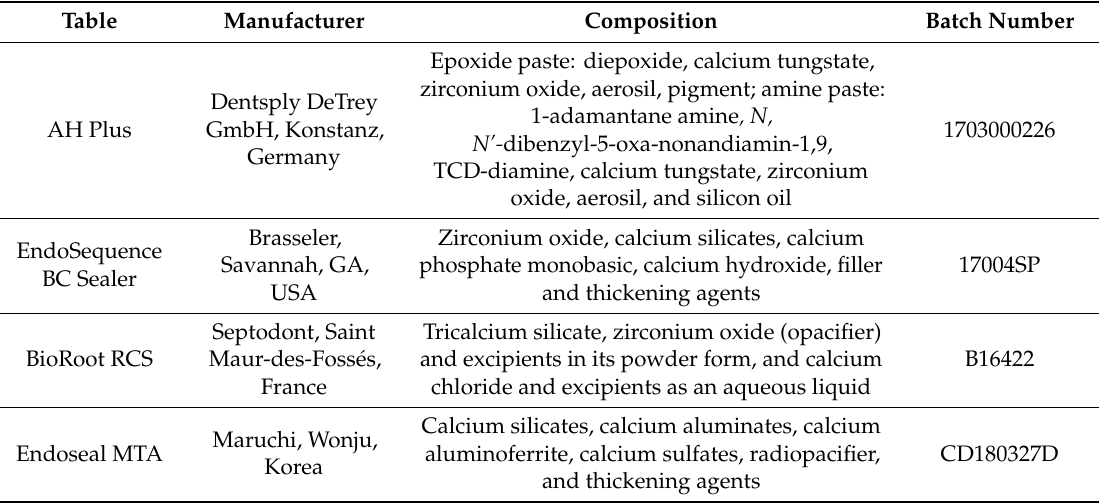
Table 1. Manufacturer and chemical composition of experimental sealers.